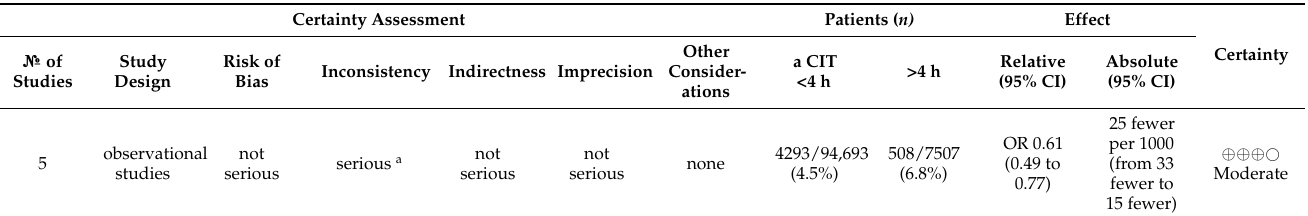
Table A1. Summary of findings with the level of evidence estimated by the Grade-tool for delayed graft